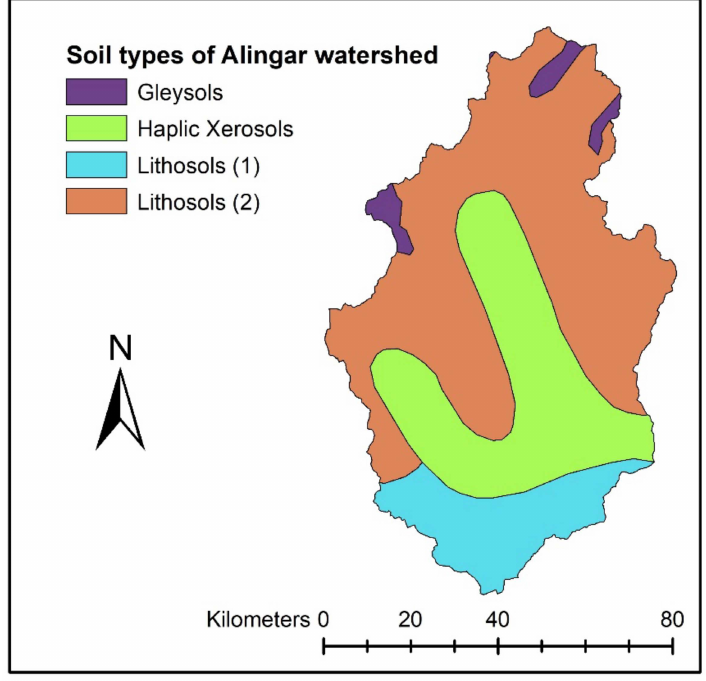
Figure 5. Spatial portrayal of different soil types of the study